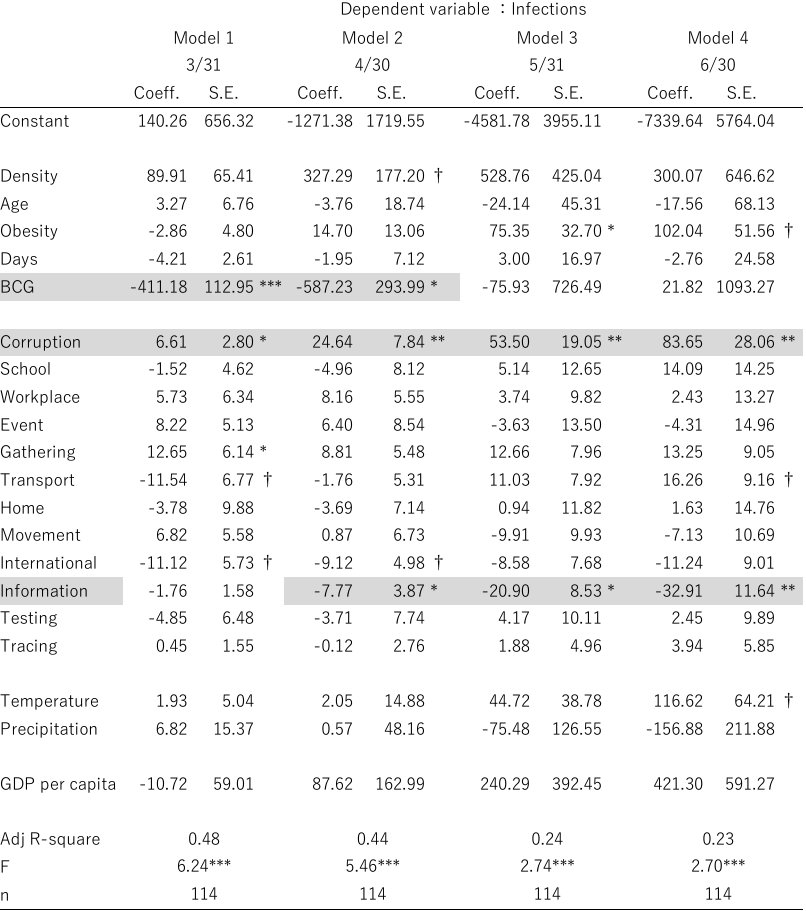
Table 2a. Results of multiple regression analyses (least-squares